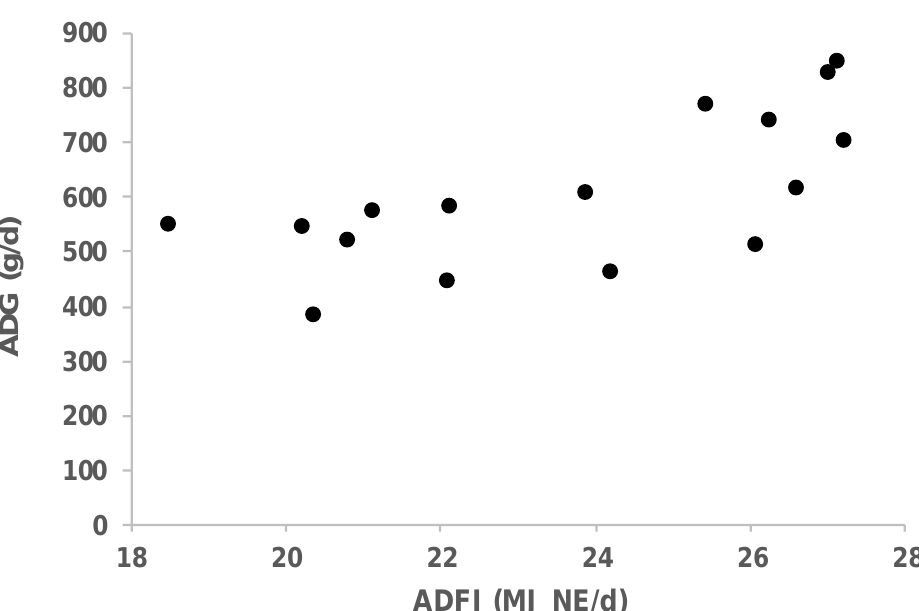
Figure 2. Relationship between average daily feed intake (ADFI, MJ NE / d) and average daily gain (ADG, g / d) for nine local breeds during the period 40–100 kg BW (see correspondence between points’ values and InraPorc profiles in Table 2).